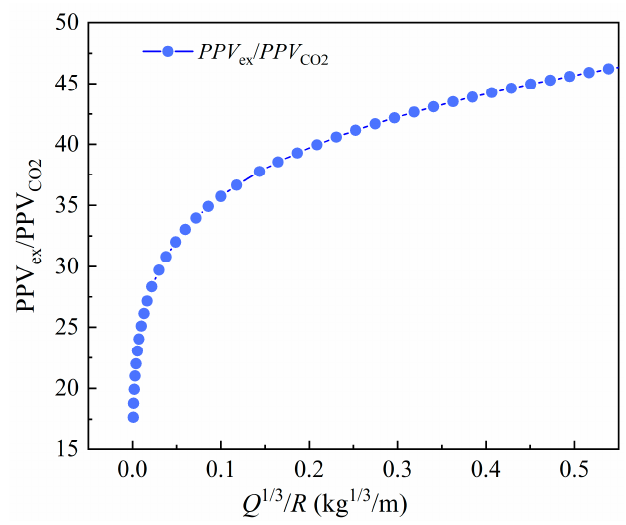
Figure 9. Peak particle velocity (PPV) comparison.